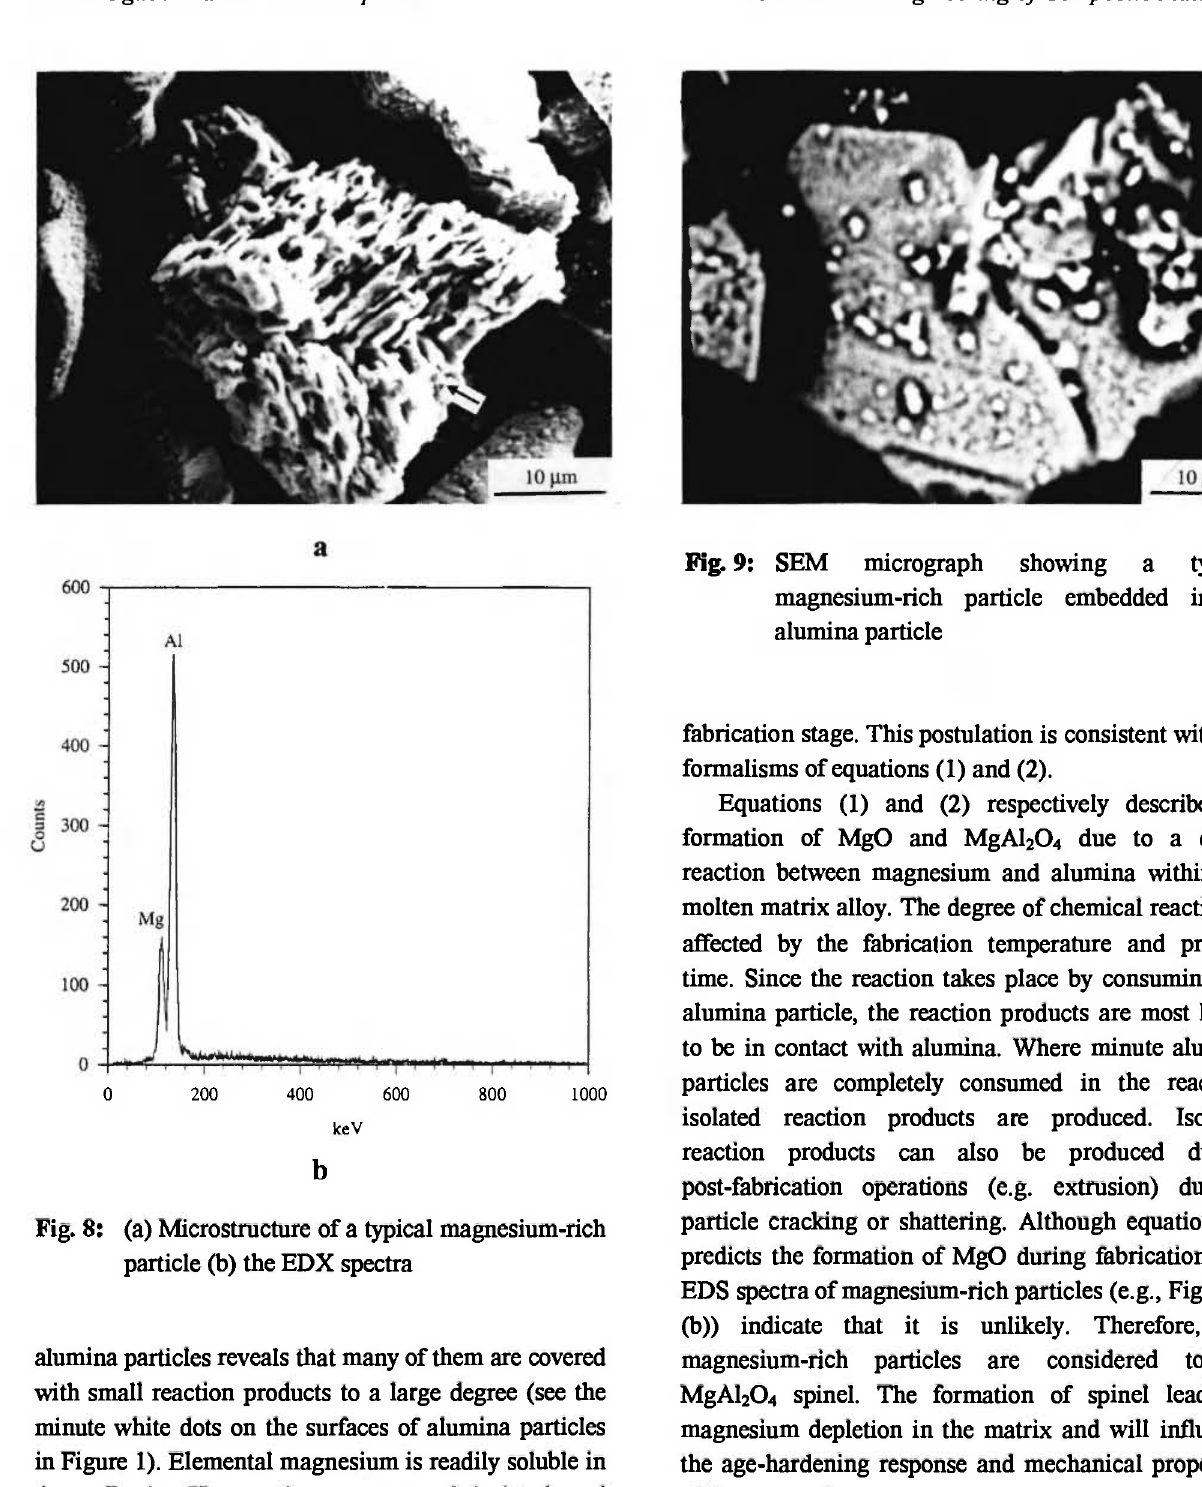
Fig. 8: (a) Microstructure of a typical magnesium-rich particle (b) the EDX spectra